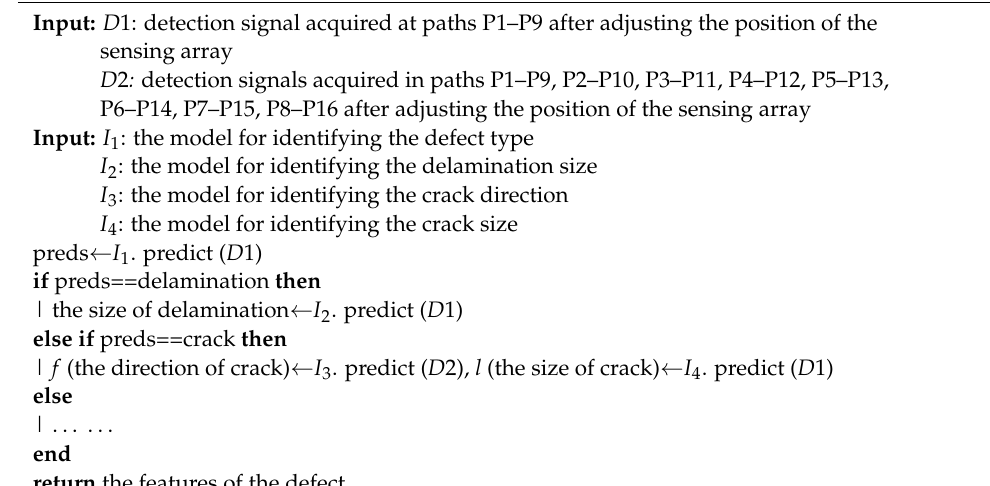
Algorithm 2: Feature identification by ML models